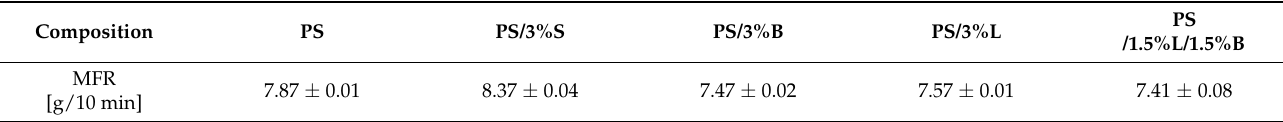
Table 3. Summary of the obtained MFR results.